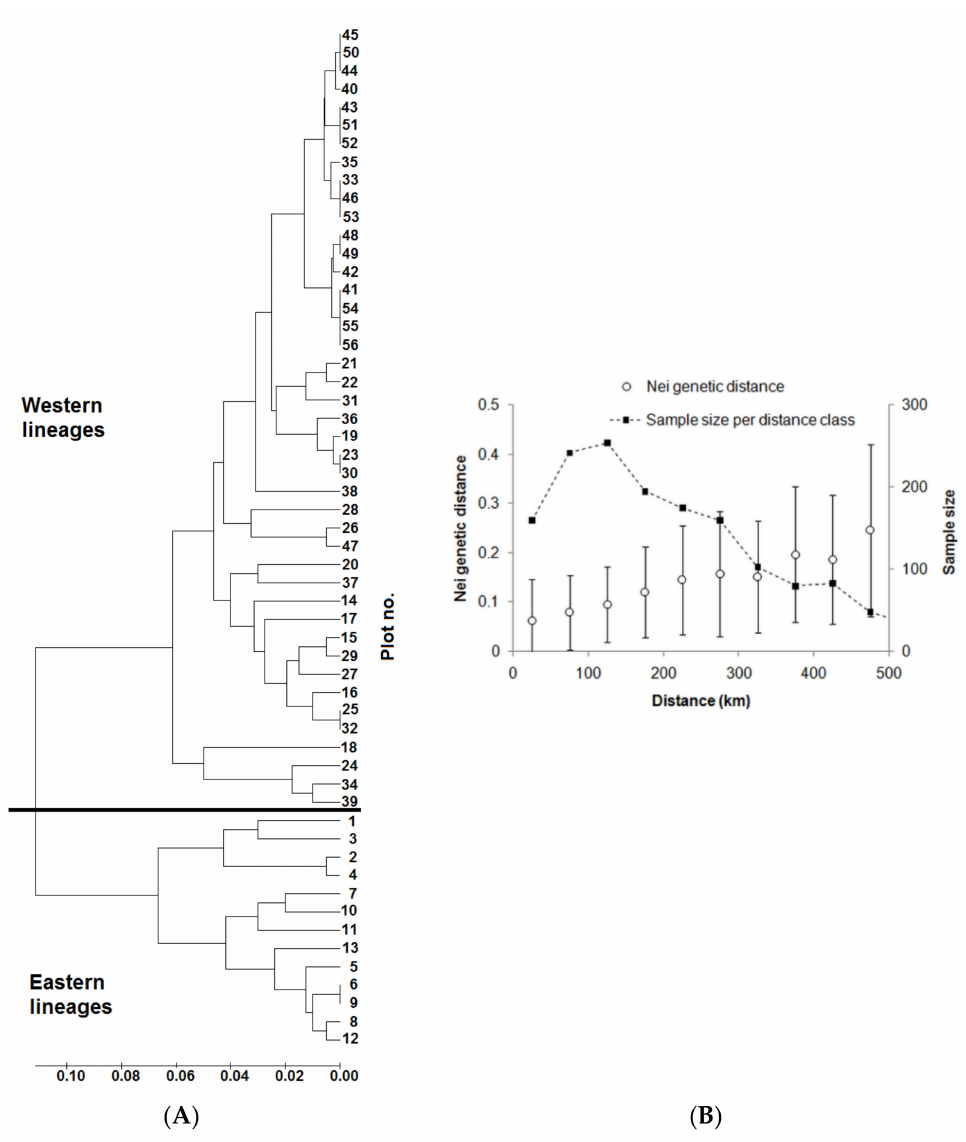
Figure 4. UPGMA dendrogram for the study subpopulations based on genetic distance index by Nei [50] ( A ) and genetic distances (mean ± SD) between the study subpopulations in geographic distance classes (class width = 50 km) ( B ). Table 1. Analysis of molecular variance and associated Slatkin’s R and F